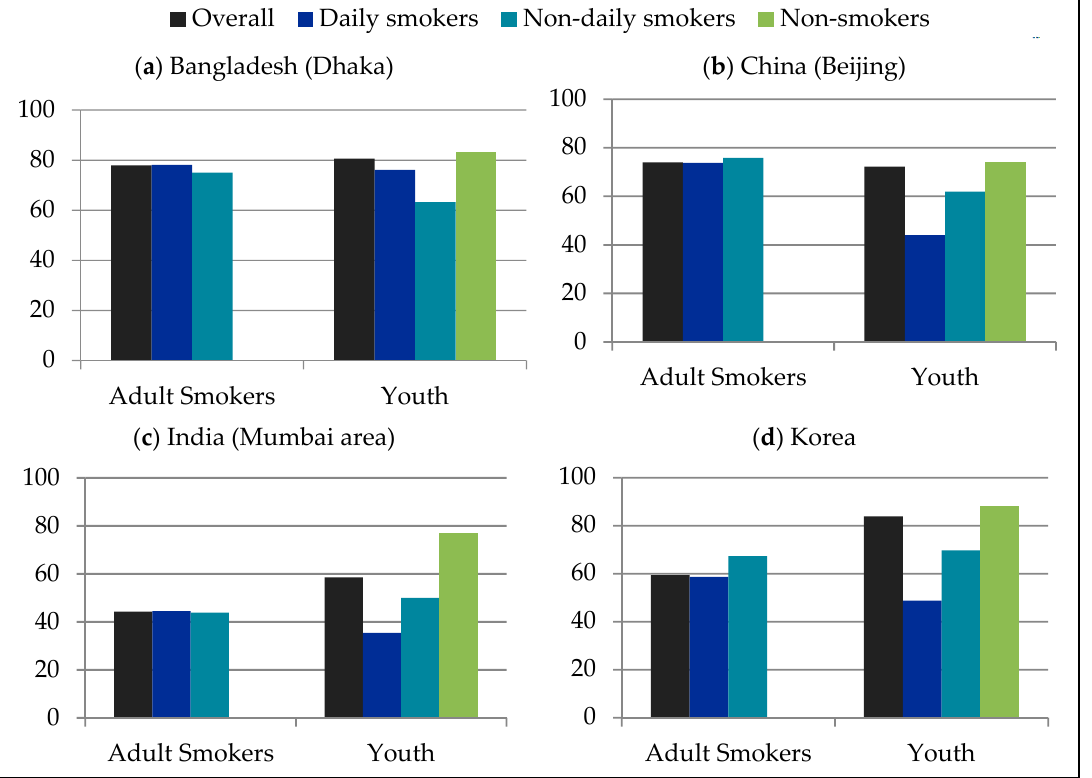
Figure 1. Percentage of respondents who said that cigarette packages should have “More health information” (vs. less/same), by country and smoking status.